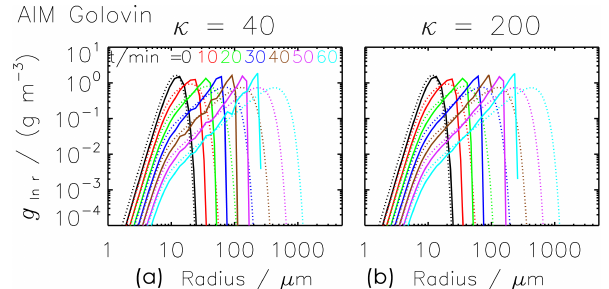
Figure 9. Mass density distributions obtained by AIM for the Golovin kernel from t 0 to 60min every 10min (from black to = cyan; see legend). The dotted curves show the reference solution; the solid curves show the AIM simulation results (ensemble aver- Figure 10. Moments λ 0 and λ 2 as a function of time obtained by ages over 50 realisations). The parameter settings are probabilistic AIM for the Golovin kernel. The black diamonds show the reference singleSIP-init with weak threshold η 10 − 9 , (cid:49)t 1s and κ 40 = = = solution. The curves depict the AIM results (averages over 50 real- (left) or κ 200 (right). = isations). The default settings are probabilistic singleSIP-init with weak threshold η 10 − 9 , κ 40 and (cid:49)t 1s. Left column: de- = = = fault simulation (red), larger time step ( (cid:49)t 10 s , blue) and more = SIPs ( κ 200, brown). Right column: ν const -init (red) and ν draw - = init (blue) with N SIP 160. In all panels, the curves are on top of = each